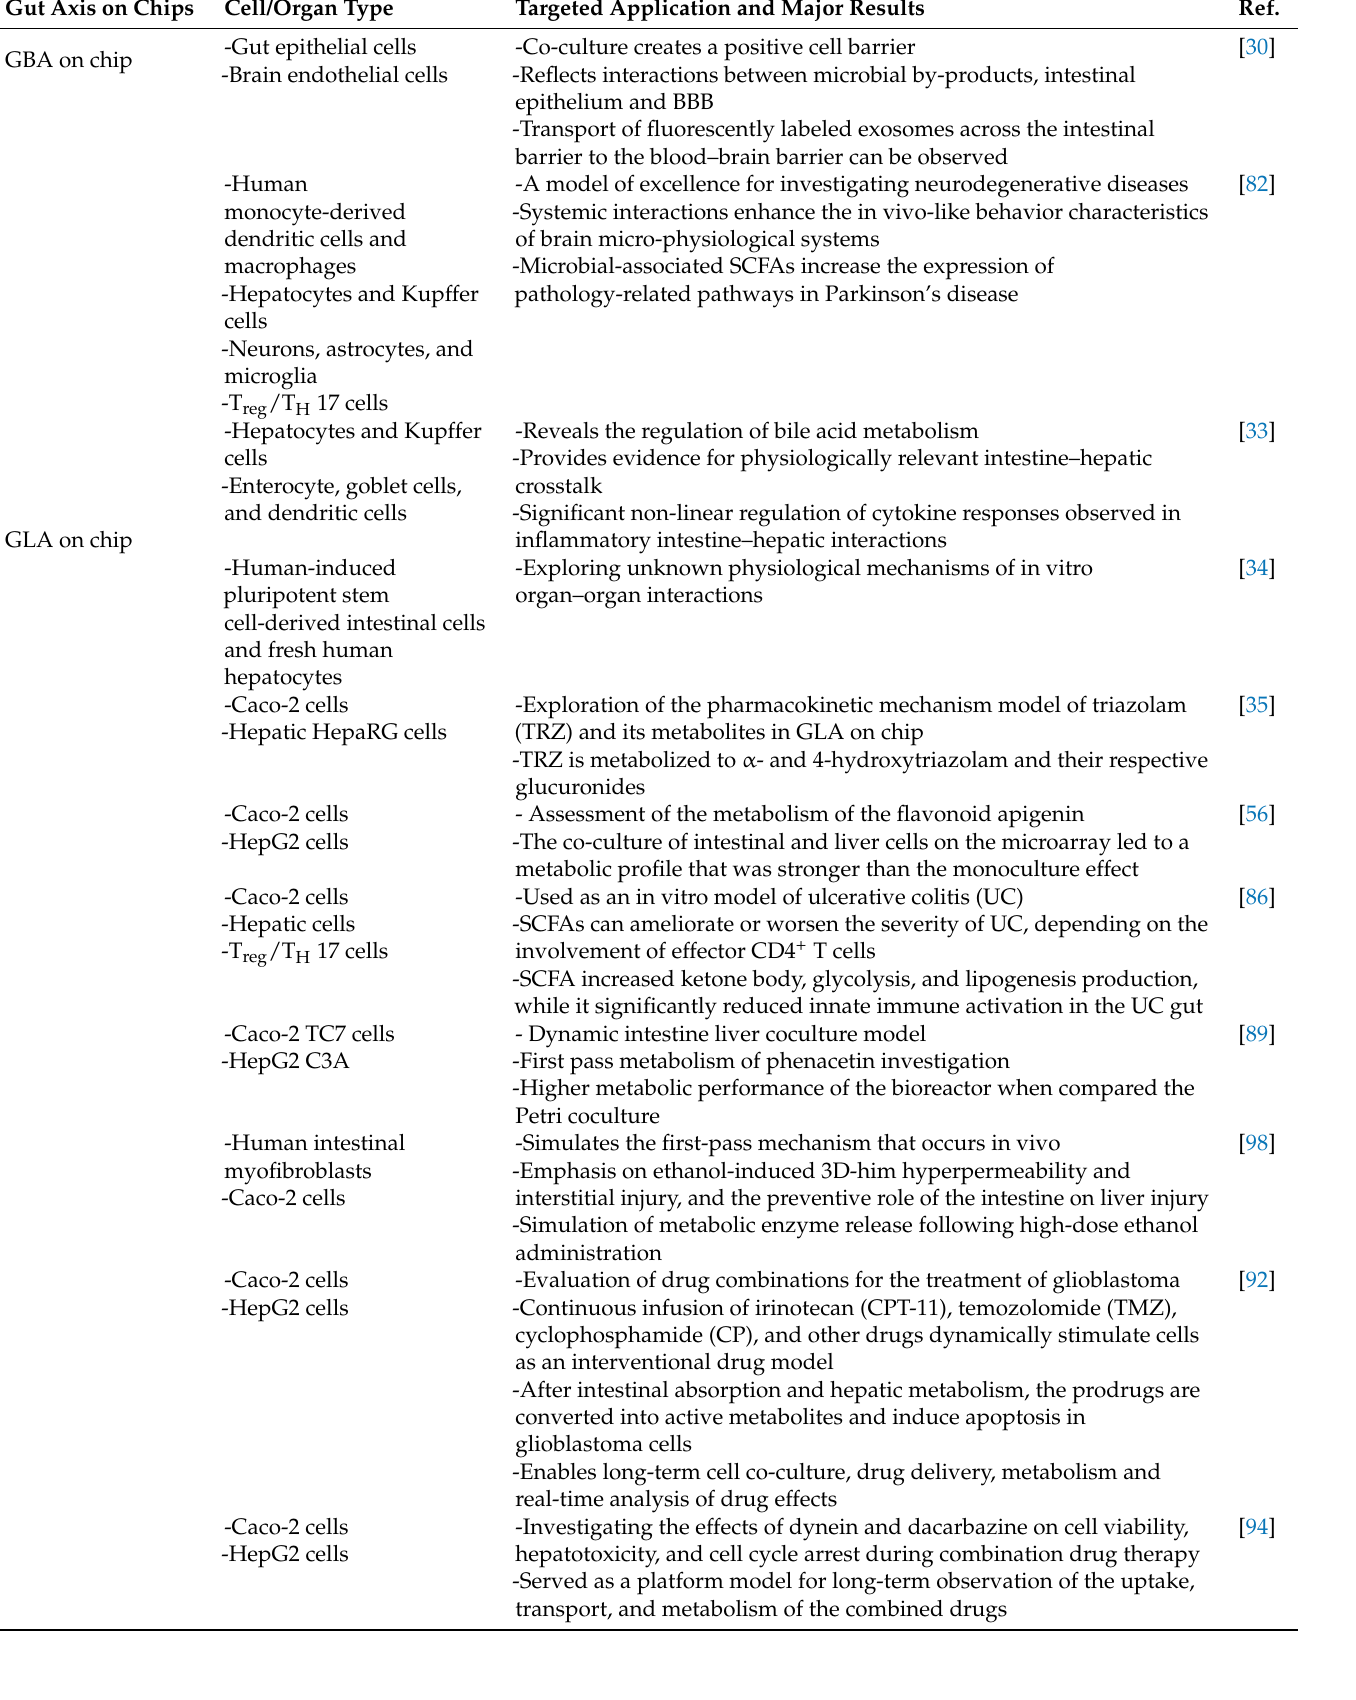
Table 1. Crosstalk on the “gut axis” associated organ reproduced in the gut-on-chip device. Gut Axis on Chips Cell/Organ Type Targeted Application and Major Results